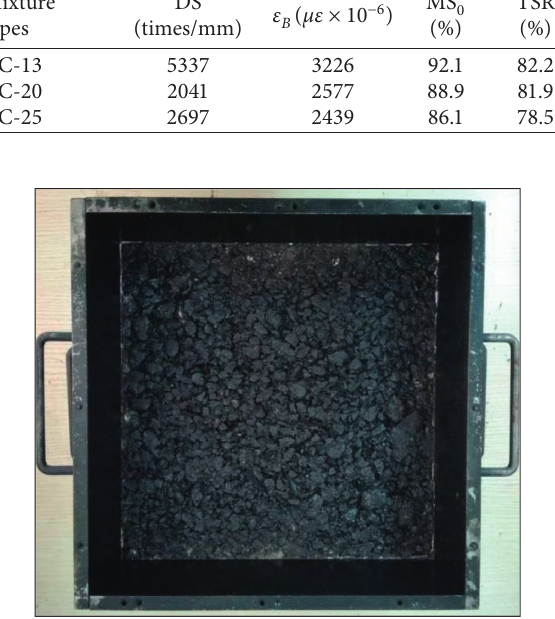
Figure 1: The prepared lower-layer specimen.